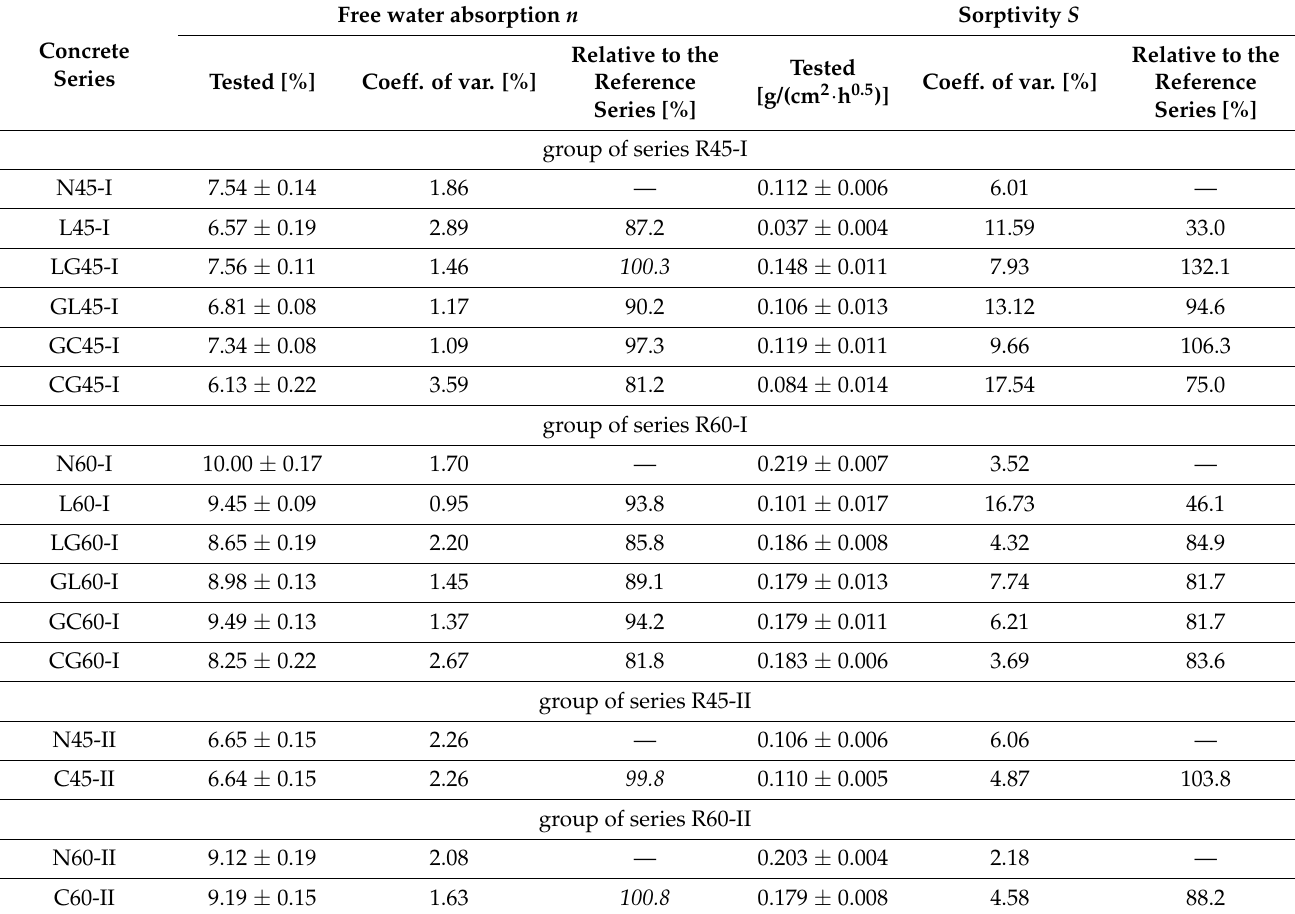
Table 5. Results of free water absorption and sorptivity